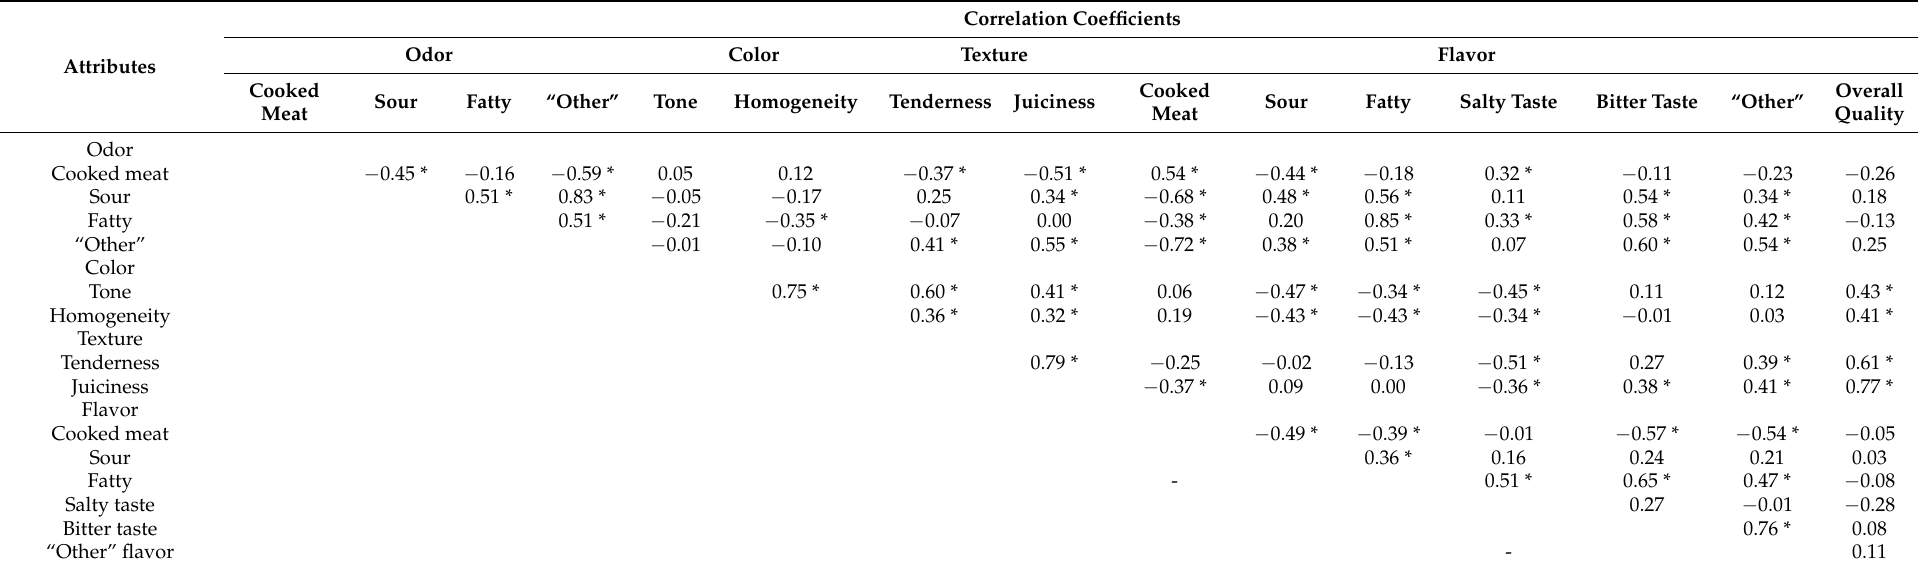
Table 5. Correlation coefficients between the tested sensory quality